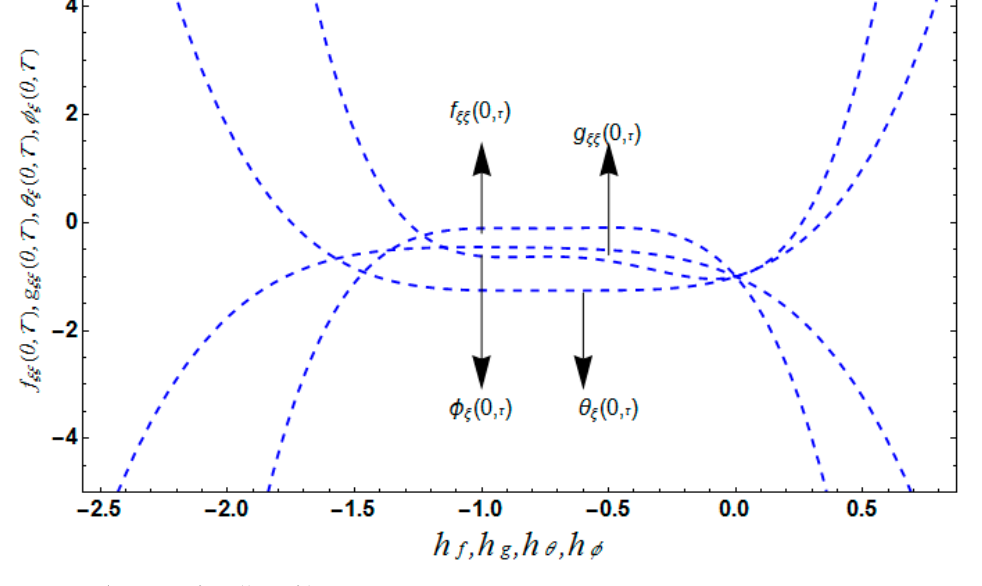
Figure 1. h -curves for all profiles.